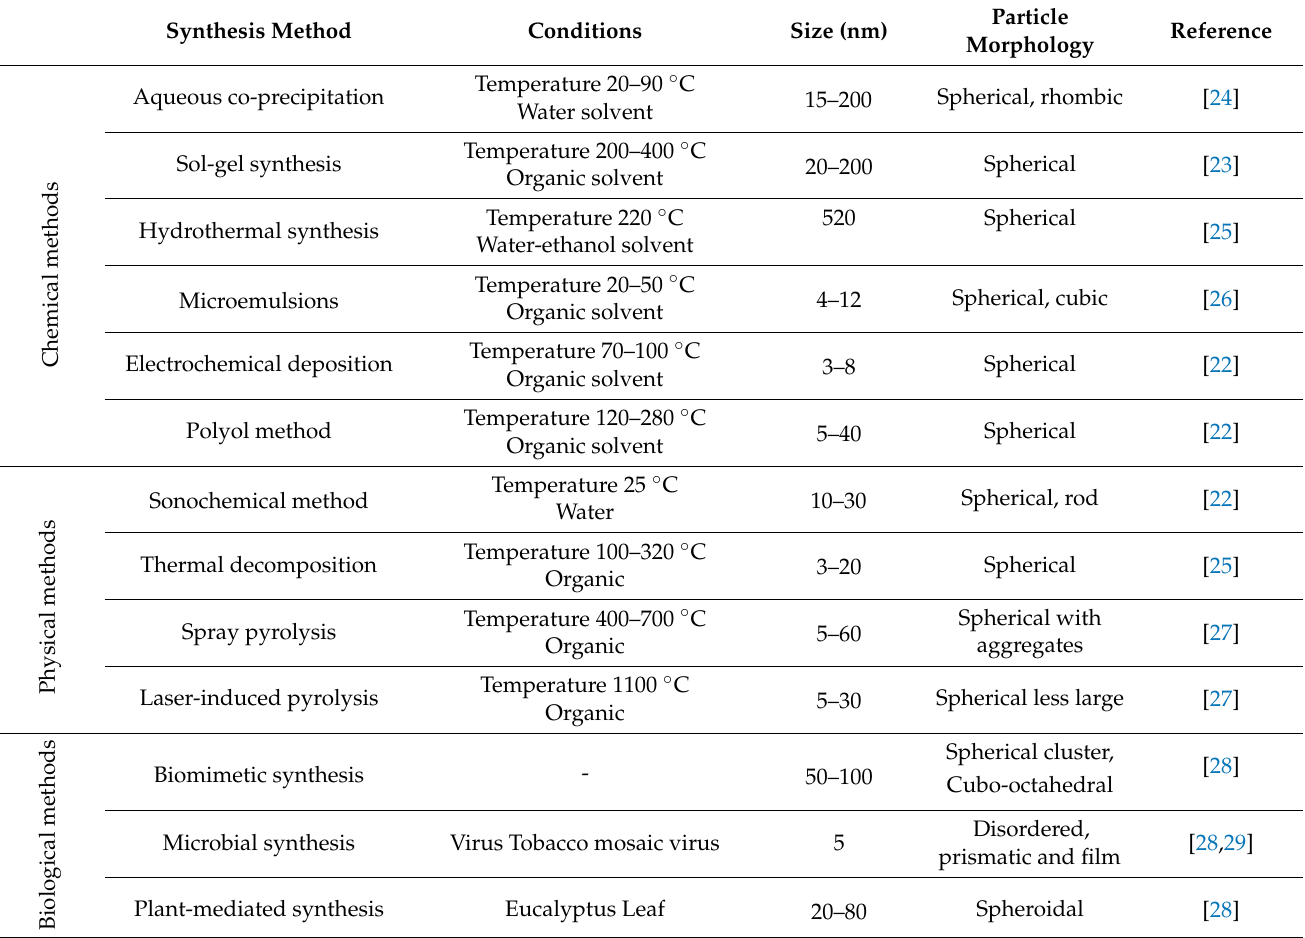
Table 1. Synthesis methods for magnetic